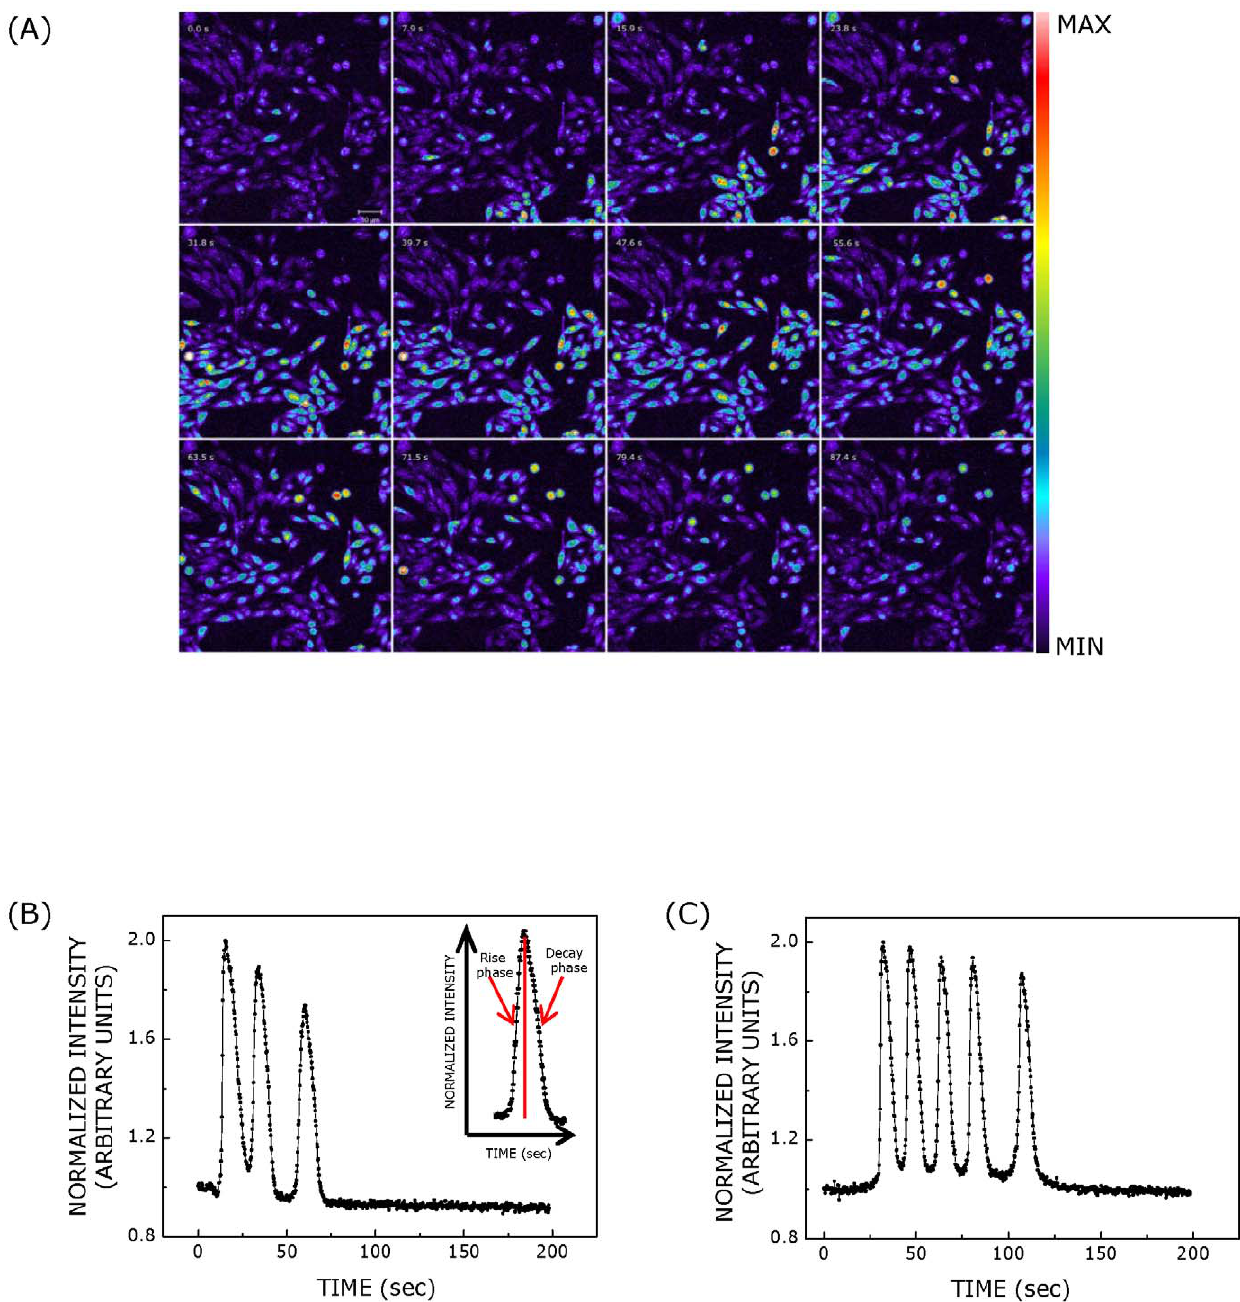
Figure 1. Calcium response in CHO-5-HT 1A R cells upon stimulation with serotonin or ATP. Panel (A) shows successive images of calcium response in cells upon stimulation with serotonin acquired with a time interval of 7.9 sec. CHO-5-HT 1A R cells were loaded with Fluo-3/AM to monitor changes in cytosolic calcium concentration. Time-lapse imaging was performed with a 20 6 /0.75 NA objective. The scale bar (shown in top left panel) represents 50 m m. Similar response was observed when cells were stimulated with ATP. Representative temporal profiles of calcium response induced by either (B) serotonin or (C) ATP are shown. The concentration of serotonin used was 100 m M and that of ATP was 500 nM, respectively. Both serotonin and ATP induce the occurrence of multiple spikes consisting of rise and decay phases. A typical calcium spike with rise and decay phases is shown in the inset in panel (B). The temporal profile of calcium response was intensity normalized such that the maximum and minimum (basal) intensities corresponded to values 2 and 1, respectively. See Materials and Methods for more details.